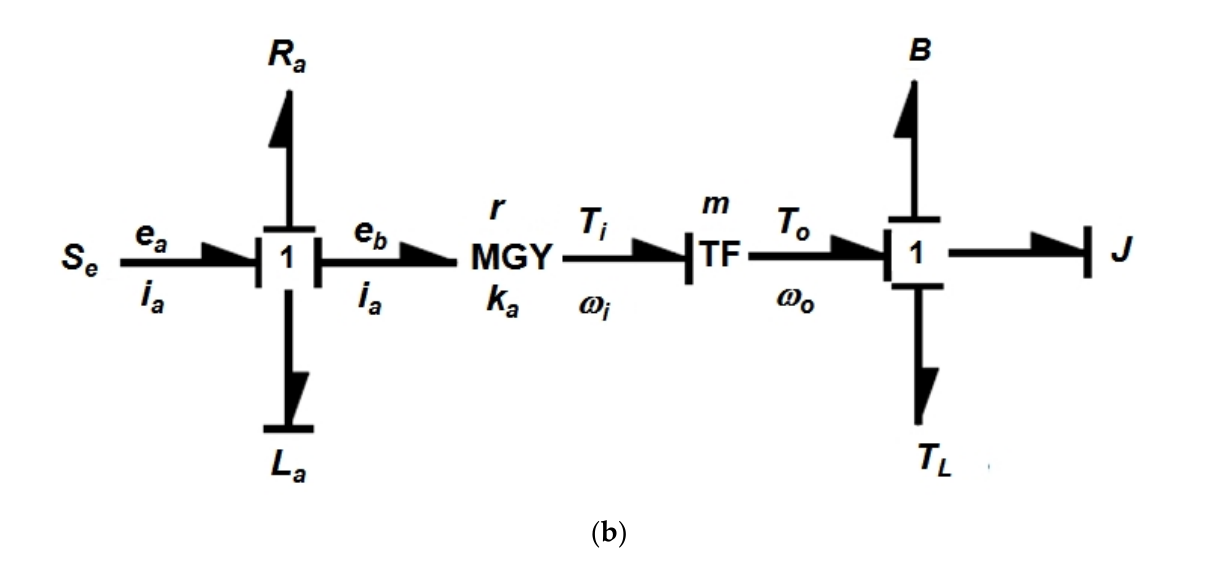
Figure 9. Design idea of an ice-maker system. ( a ) Illustrative drawing of auger motor, ice crusher, ice bucket, etc. ( b ) Bond graph formulation of ice-maker.